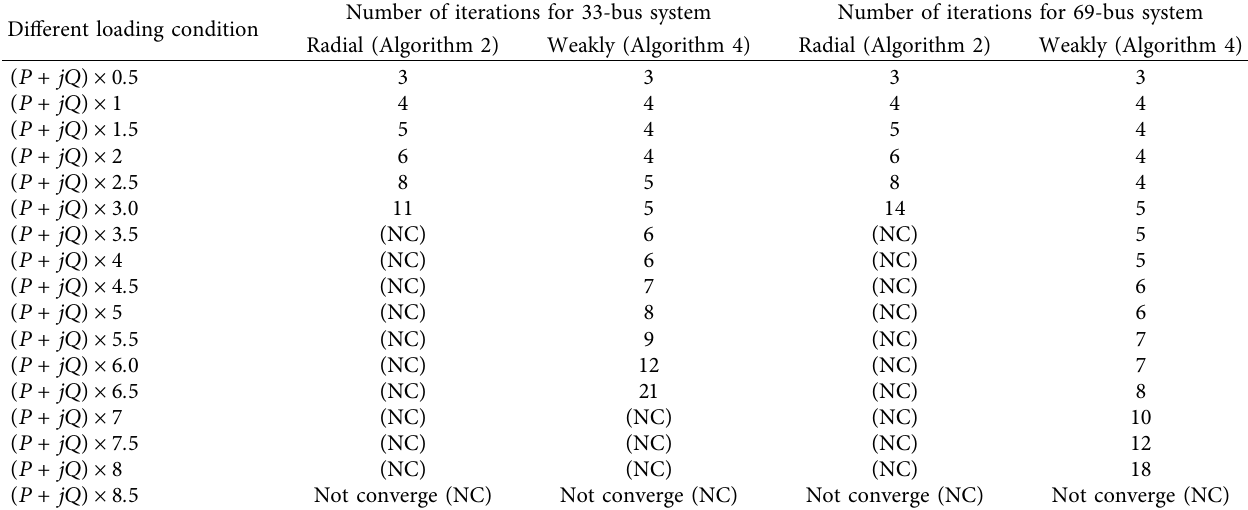
Table 9: Diferent loading conditions in the 33-bus and 69-bus weakly meshed system. Diferent loading